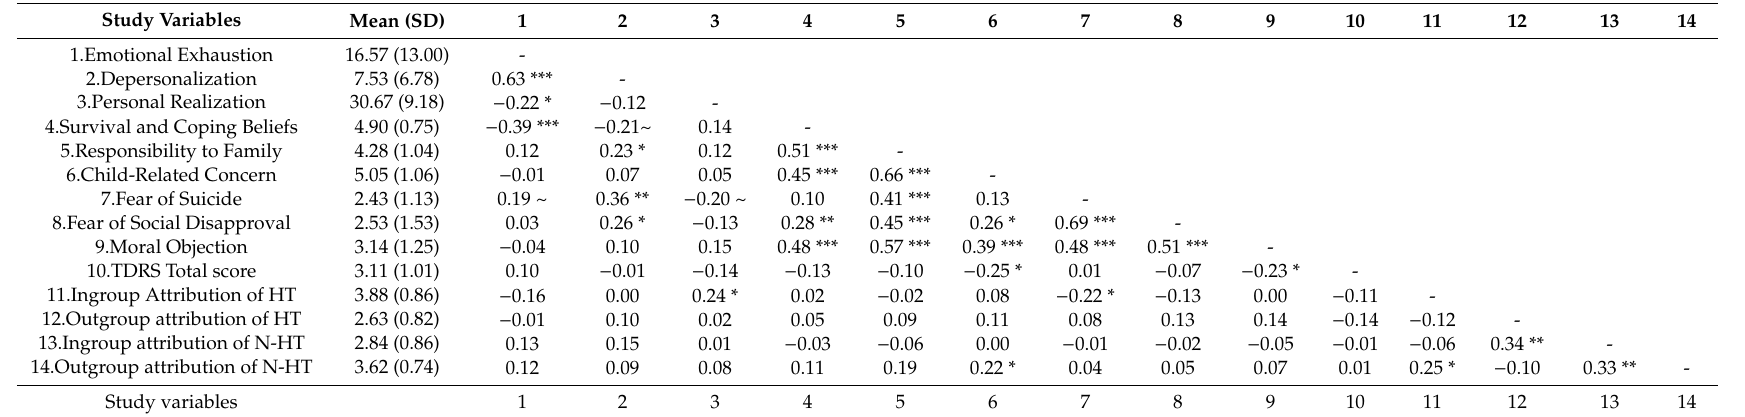
Table 2. Descriptive statistics (range, mean, standard deviation, Cronbach’s alpha) and correlations between all study variables (N = 86). Study